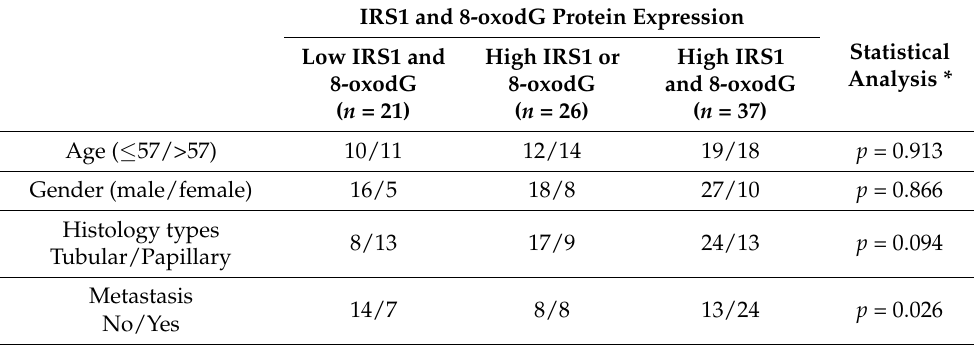
Figure 3 . Expression of IRS1 in an oxidative-stress-resistant cholangiocyte cell line (ox-MMNK1-L). ( A ) Relative IRS1 mRNA expression levels in MMNK1 and ox-MMNK1-L cells assessed by real- time PCR. * p -value < 0.05 compared with MMNK1. ( B ) Immunocytochemical staining of IRS1 in ox-MMNK1-L and MMNK1 cells. 2.3. Transient IRS1 Knockdown in CCA Cell Lines To demonstrate that IRS1 expression levels play critical roles in CCA progression, IRS1 knockdown CCA cell lines were used. Expression of IRS1 at the mRNA and protein levels was observed in MMNK1 and five CCA cell lines (KKU-100, KKU-023, KKU-055, KKU-213A, and KKU-213B). The mRNA levels of IRS1 were high in KKU-023, KKU-055, KKU-213A, and KKU-213B cells when compared with MMNK1 cells (Figure 4A). IRS1